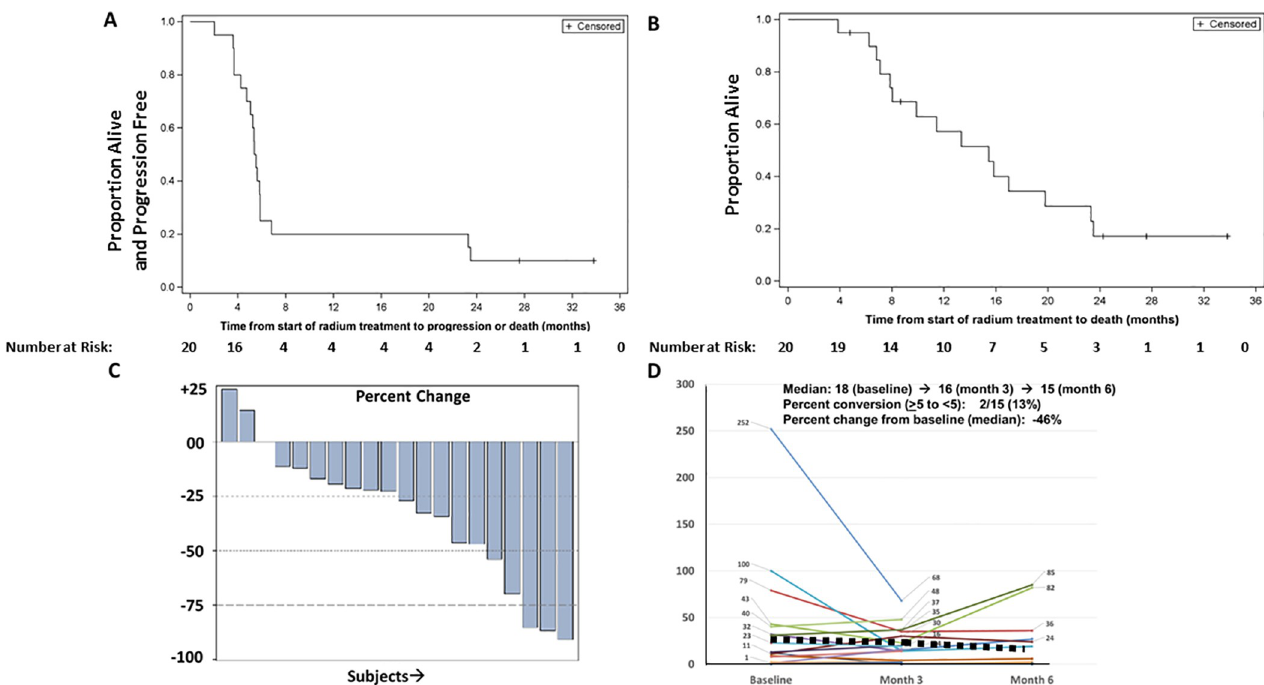
Fig 2. A. Kaplan-Meier plot of progression free survival of patients treated with radium-223. B . Kaplan-Meier plot of overall survival of patients treated with radium-223. C . Waterfall plot of serum bone alkaline phosphatase declines with radium-223 over time. D. Spider plot of CellSearch CTC enumeration and changes over time during radium-223